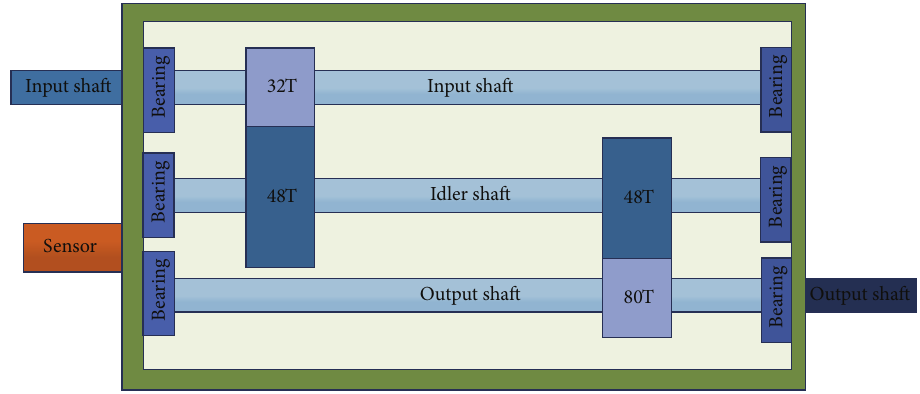
Figure 6: Schematic of the apparatus.